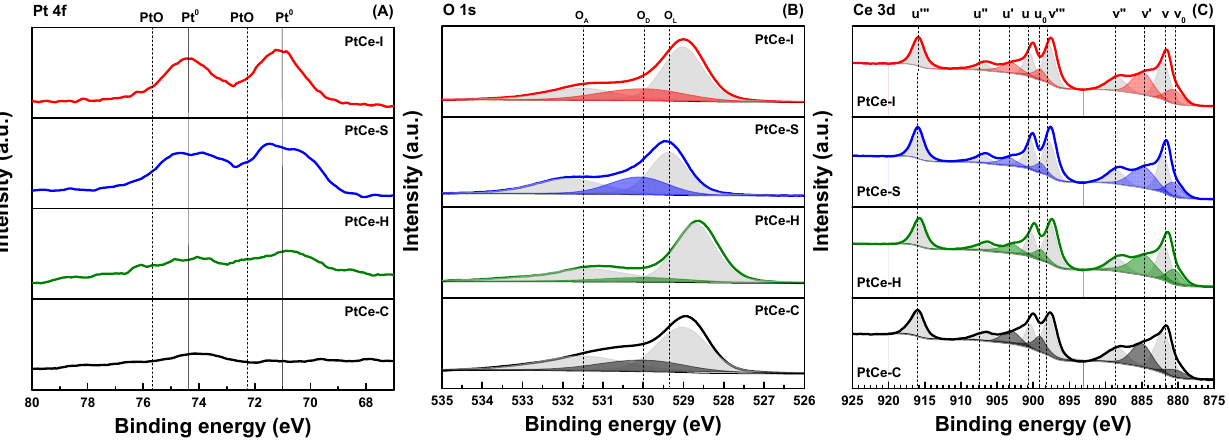
Figure 3. XPS spectra of reduced CeO 2 -supported Pt catalysts prepared by various synthesis methods. ( A ) Pt 4f; ( B ) O 1s; ( C ) Ce 3d.